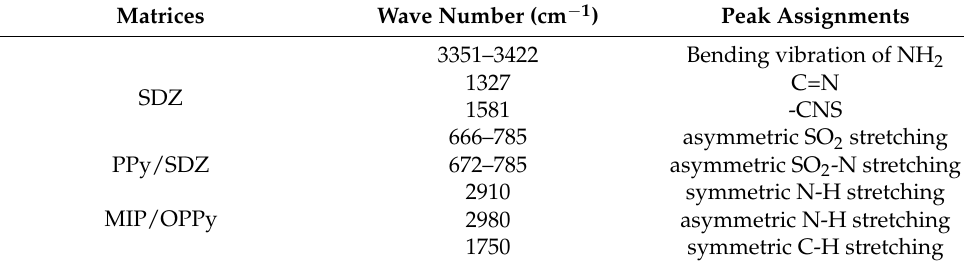
Table 1. FT-IR peak assignments for SDZ, PPy/SDZ, and MIP/OPPy.